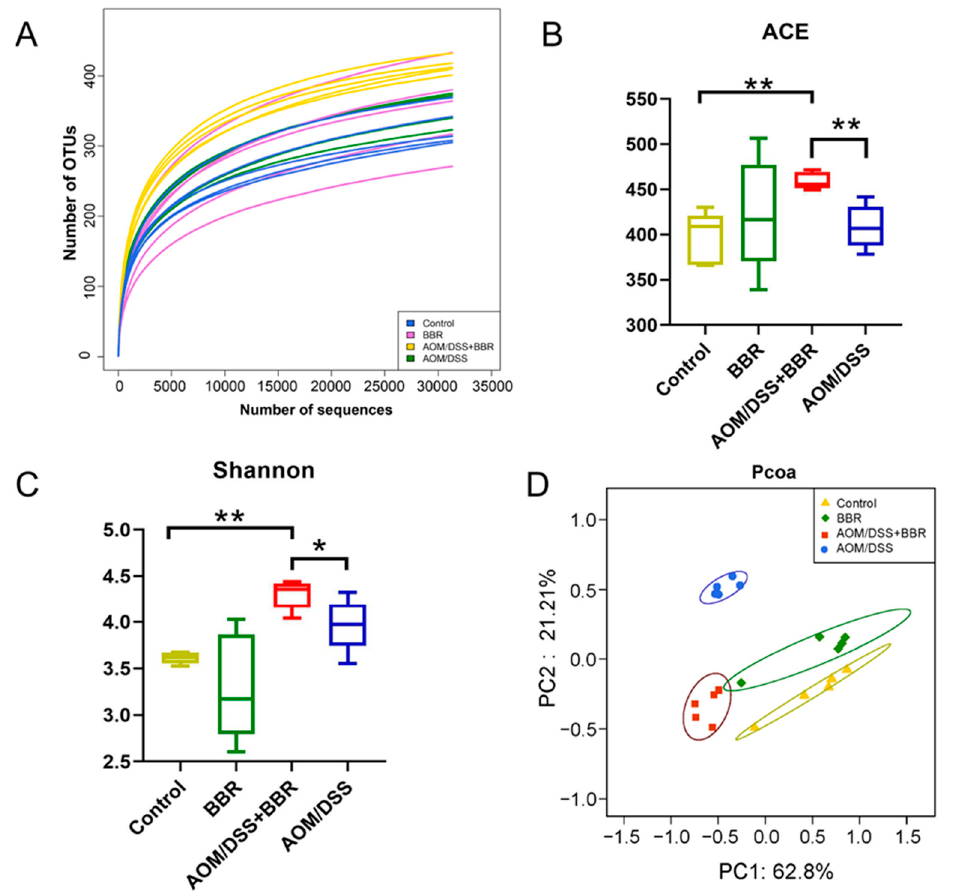
Figure 6. Analysis of gut microbiota richness and diversity in the Control, AOM/DSS, BBR, and AOM/DSS + BBR groups. ( A ) The rarefaction curves show the numbers of unique operating taxonomic units (OTUs) in each group ( n = 5). The ACE index ( B ) and Shannon ( C ) index of fecal samples in each group ( n = 5). ( D ) Weighted UniFrac principal coordinate analysis (PCoA) based on OTU abundance ( n = 5). Data are presented as mean ± SEM of the indicated number of independent experiments. * indicates p < 0.05, ** indicates p < 0.01.